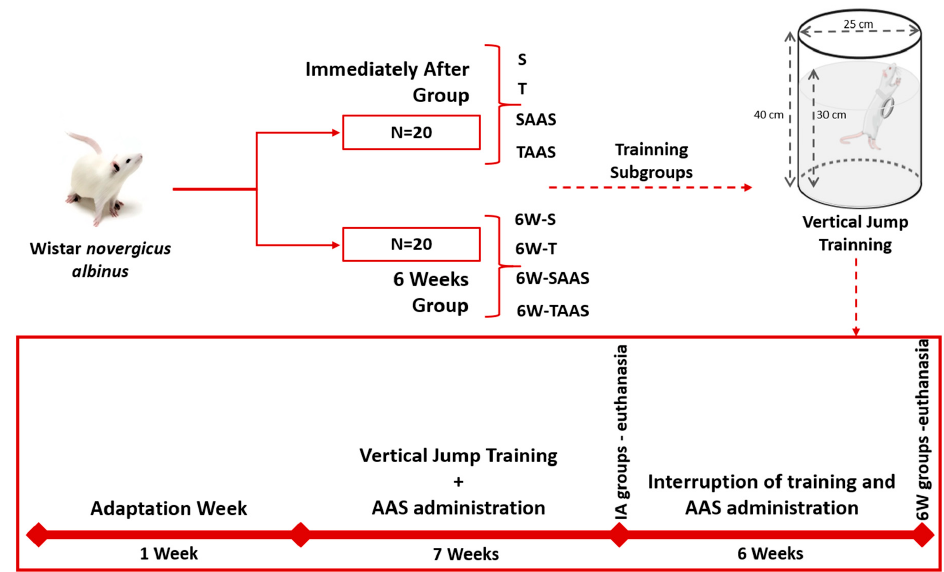
Figure 1. Experimental design. Schematic illustration of the methodological sequence followed in the